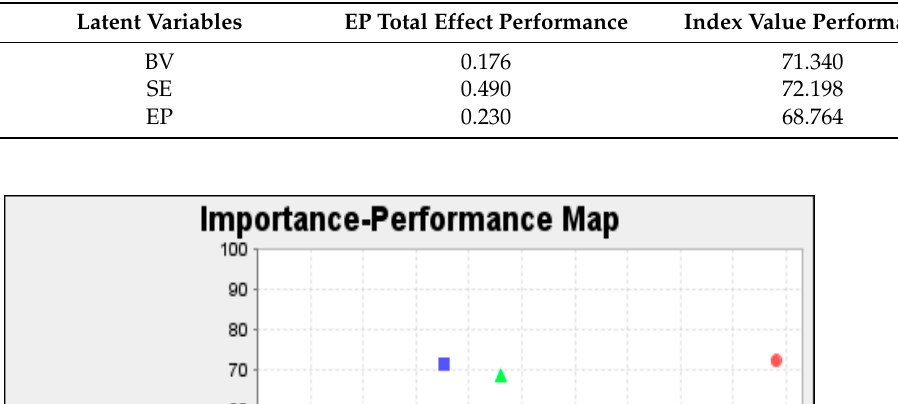
Table 9. IMPA results.